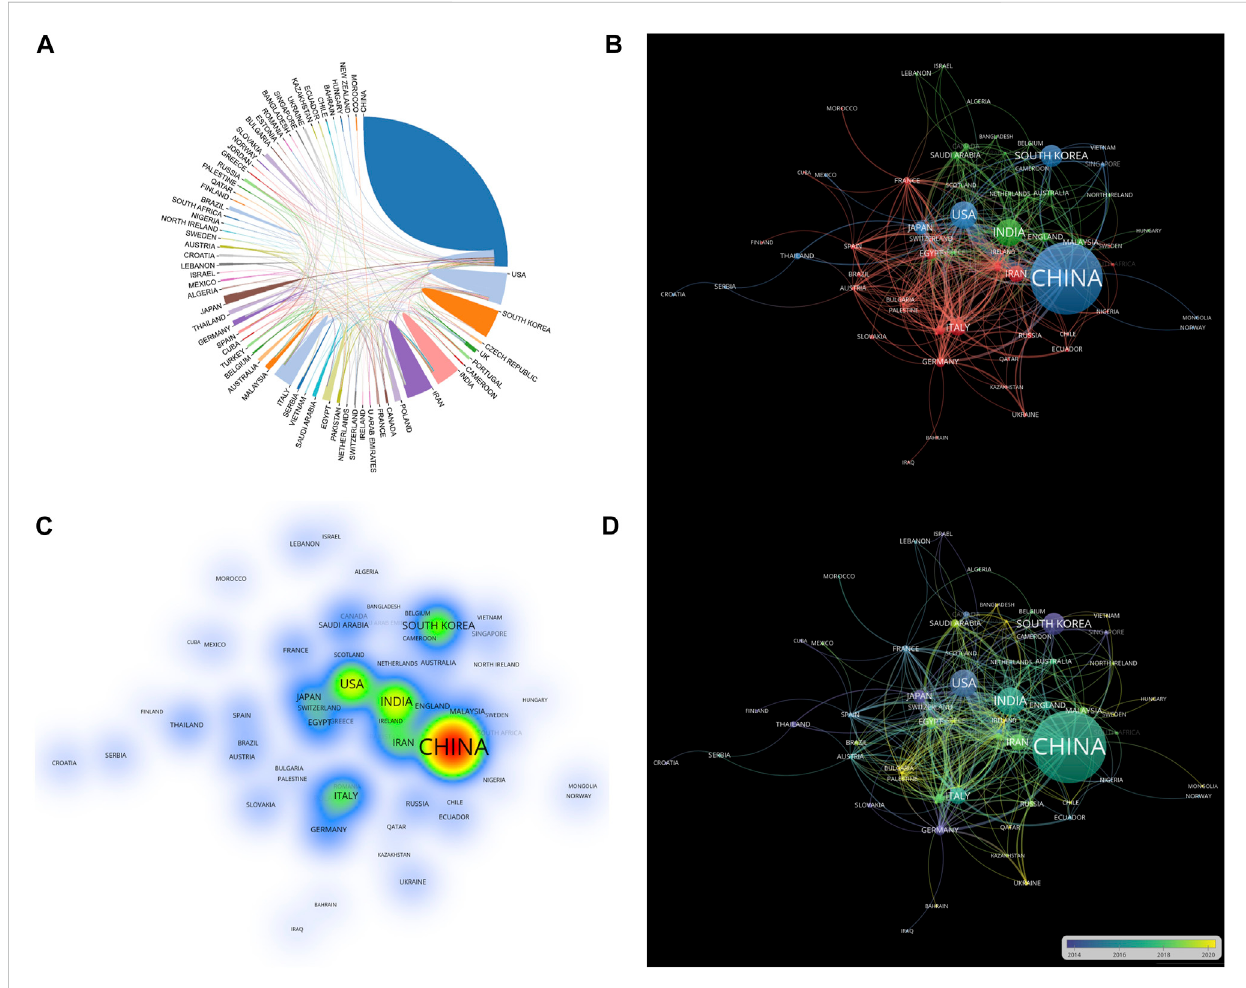
FIGURE 3 Overviewofnationalpublications. (A) Thescienti fi ccollaborationsamongworldwidecountries. (B) Visualanalysisofcooperationbetweencountries based on VOSviewer. (C) A density visualization map of number of publications in each nation. (D) Median time chart of the number of articles issued by each country.